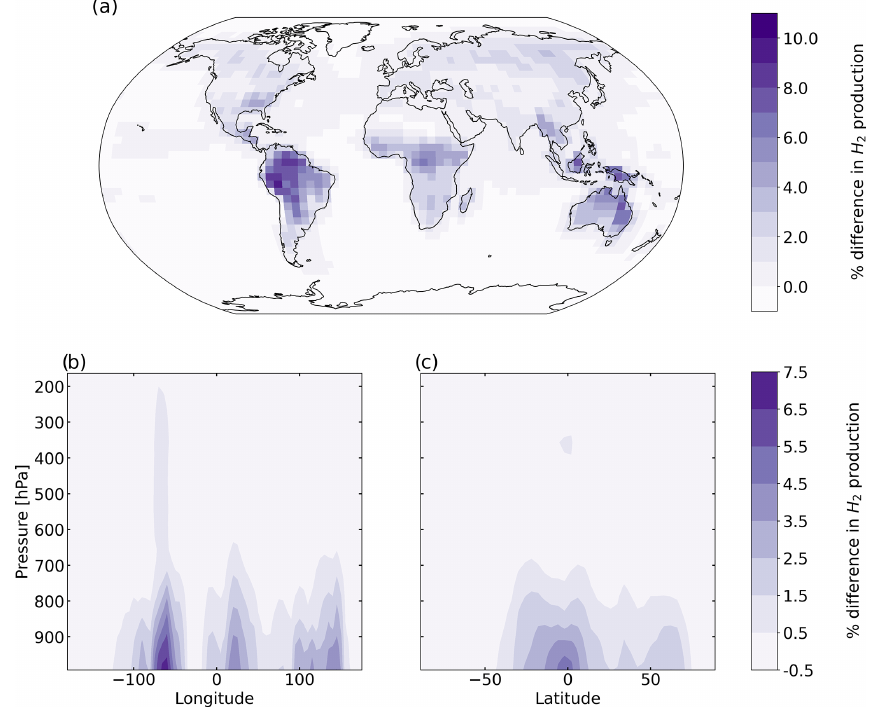
Figure 6. Percentage difference in tropospheric H 2 chemical production between the aldehyde photolysis scenario (with 1% H 2 quantum yield) and the baseline simulation, averaged over 2015 and 2016. Results are shown (a) spatially (summed over the tropospheric column), (b) as a function of altitude and longitude (summed over latitudes), and (c) as a function of altitude and latitude (summed over